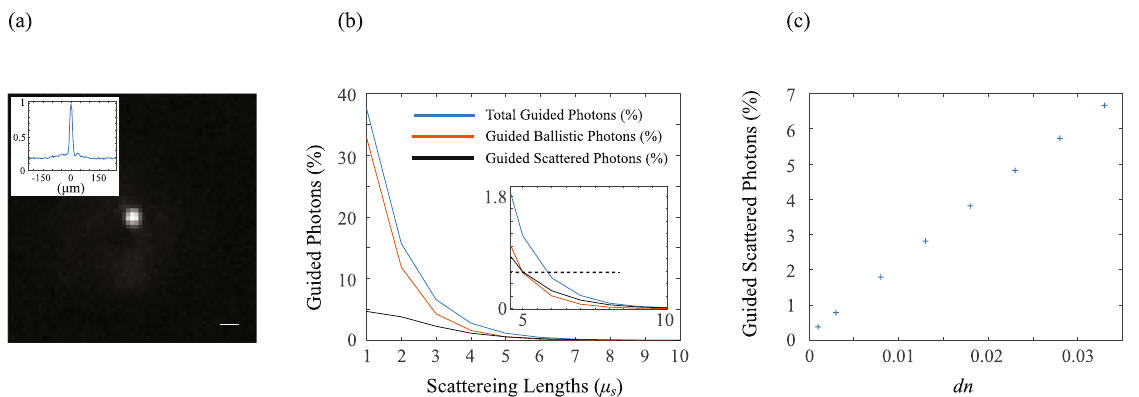
Fig. 1 Guided scattered and ballistic photons, experimental and simulated results. a A beam focused using an external lens through a 1-cm cuvette fi lled with a diluted intralipid solution (0.2 %). A sharp focal point with a contrast ratio of 5 is obtained with merely ballistic photons (scale bar = 25 µ m). b The percentage of guided photons through a waveguide with dn = 0.002 and a scattering core of g = 0.85. The dashed line in the inset represents a threshold of 0.6%. c Percentage of guided scattered photons for increasing values of dn